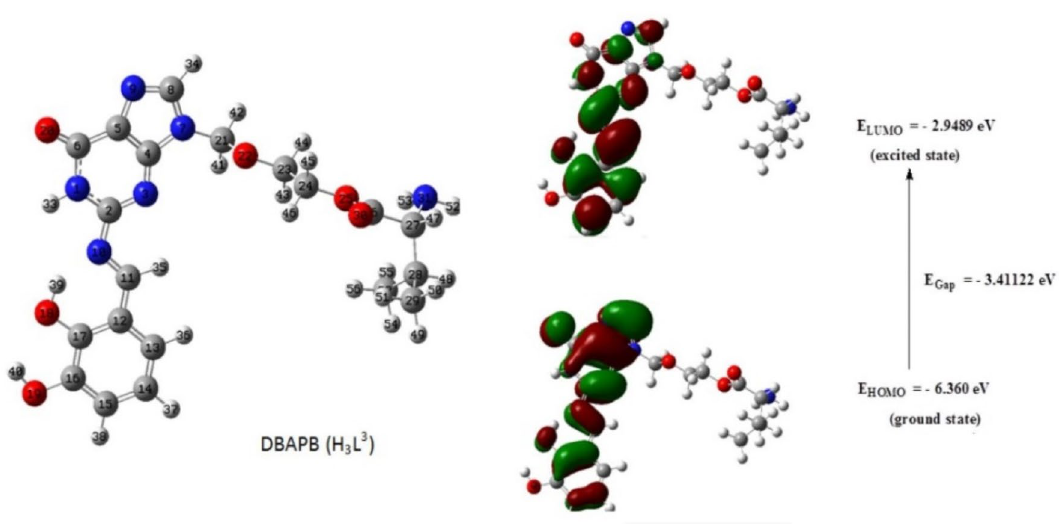
Figure 8. The optimized geometry and HOMO–LUMO energies for the ligand